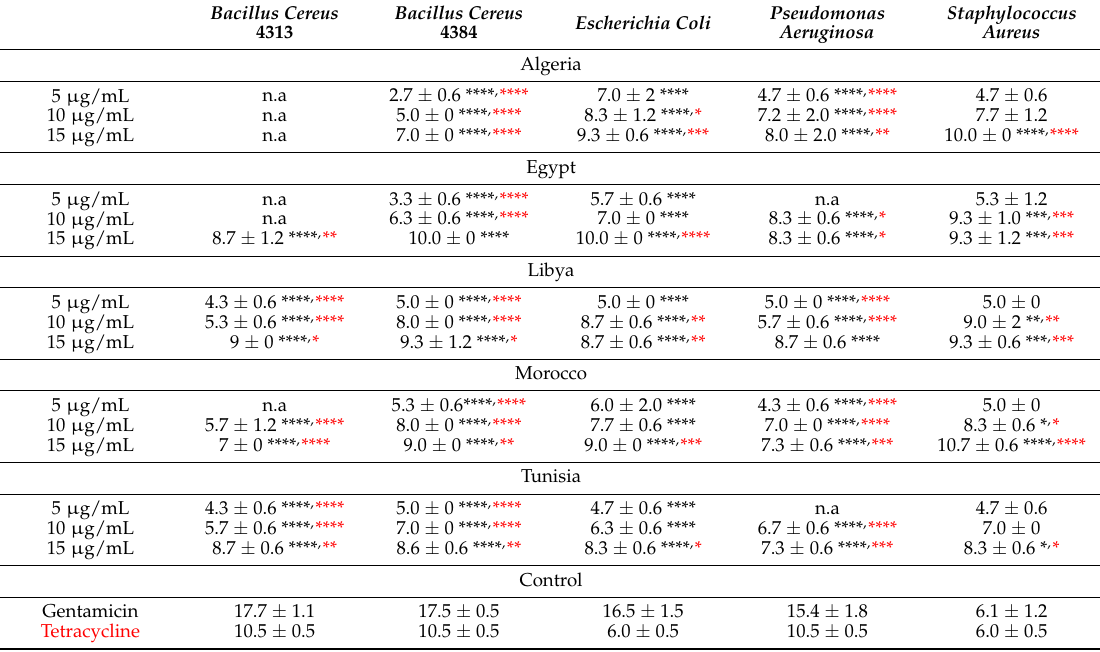
Table 2. Antibacterial activity of essential oil of P. harmala from Algeria, Egypt, Libya, Morocco and Tunisia and of the reference compounds gentamicin and tetracycline. Results are expressed as the mean of three experiments ± standard deviation.